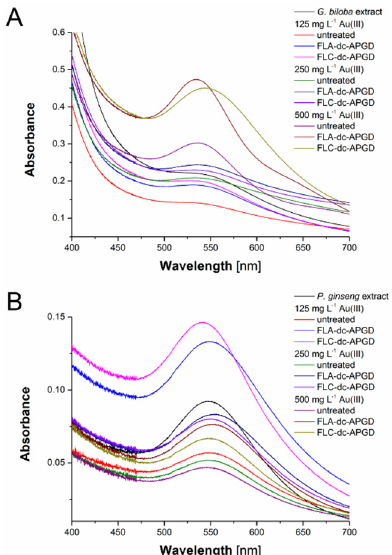
Figure 2. UV / Vis spectra of ( A ) the aqueous G. biloba leave extract and ( B ) the aqueous P. ginseng root extracts and AuNPs obtained therefrom. Table 1. Optical properties of AuNPs and absorbance (A) values at the maximum wavelength ( λ max ) of their localized surface plasmon resonance (LSPR) absorption bands.